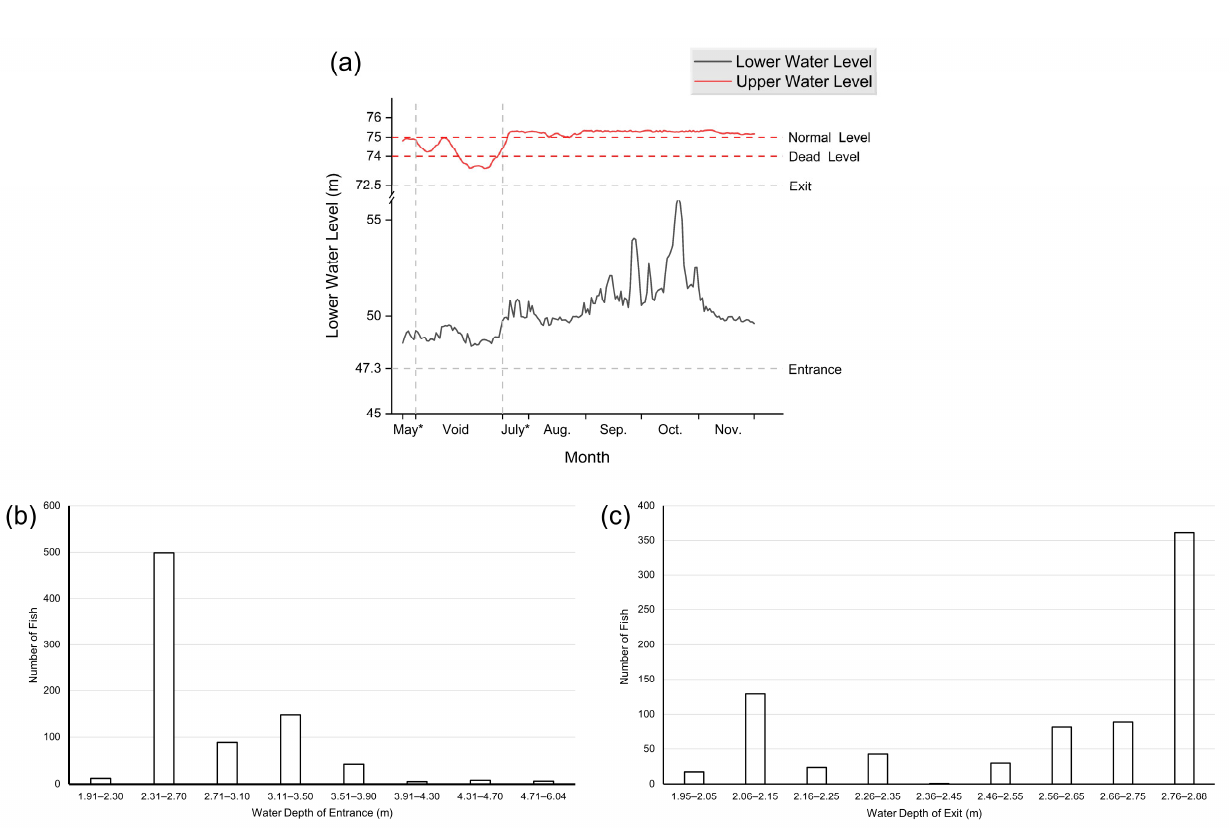
Figure 7. ( a ) Upper and lower water levels during the entire monitoring period. Relationship between the water depth of ( b ) entrance and ( c ) exit and the number of ascending fish. May* implies the periods of sampling (24 May to 28 May) and July* implies an incomplete monitoring period (17 July to 31 July). “Void” implies no sampling or monitoring data during this period.